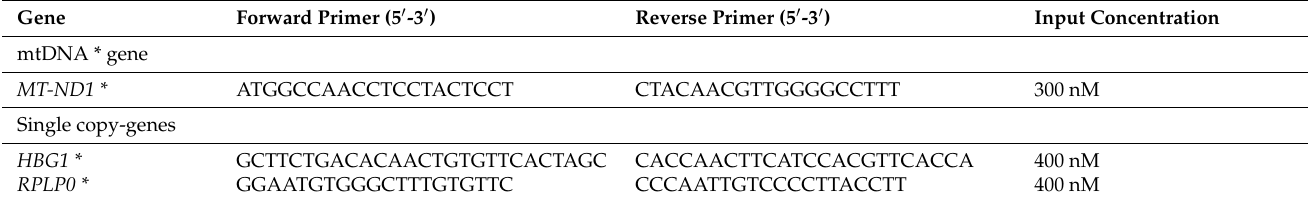
Table 3. Primer information and input concentration of mtDNA and single-copy